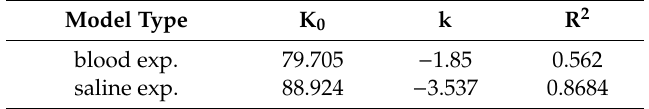
Table 2. Parameters of exponential models—y = K 0 e kx —obtained from the 0–8%